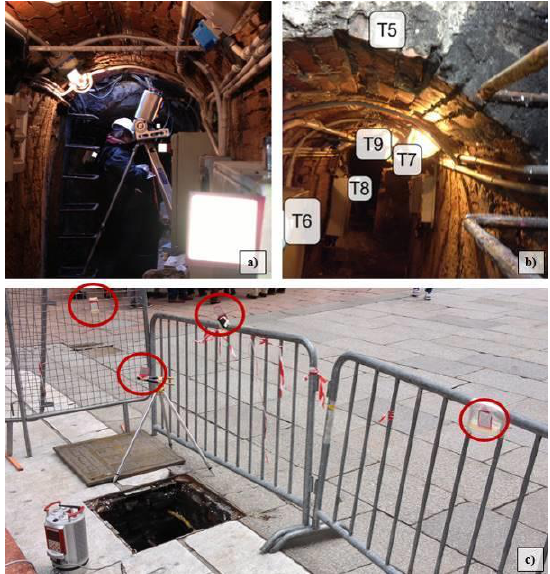
Figure 3. A phase of the underground surveying (a) and the placement of the targets used to align the clouds of the tunnels (b); some targets around the hatch used for the alignment of the above and the underground parts (c).